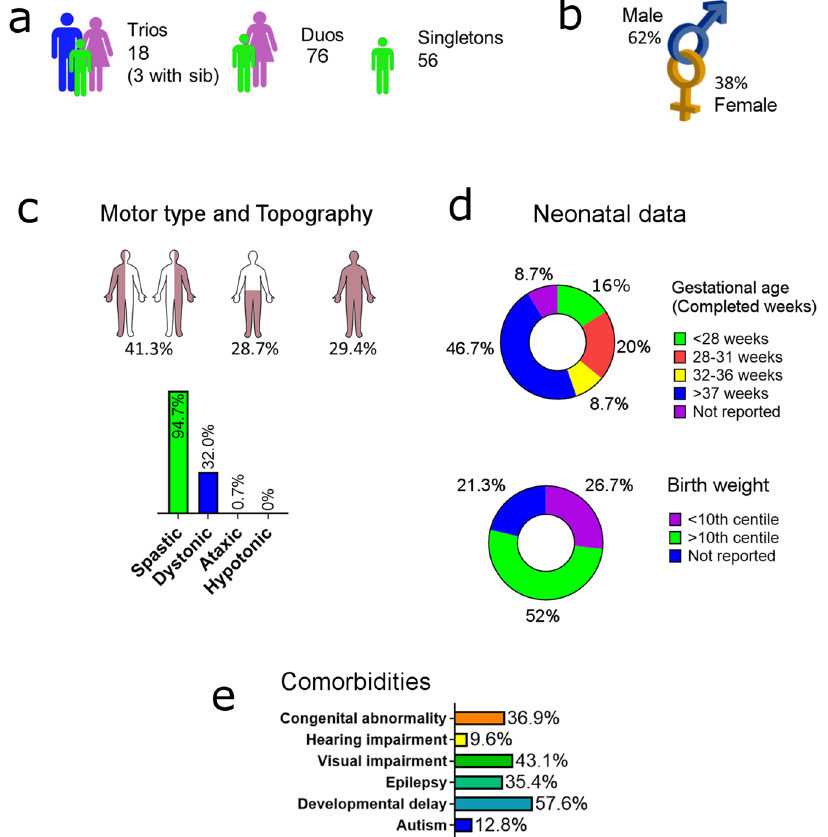
Fig. 1 Summary of clinical characteristics of the study cohort. Clinical descriptions for each individual in the cohort are in Supplementary Table 1. a Availability of parental samples. b Sex. c Motor type and Topography ( n = 150): Cases were classi fi ed according to topography categories: hemiplegia, diplegia or triplegia/quadriplegia. For motor type, cases with any report of dyskinetic/dystonic motor type are reported as dystonic. d Neonatal data: Gestational age was con fi rmed by case note review ( n = 137). Personalised birth weight centiles for this cohort were calculated using the Gestation Related Optimal Weight (GROW) software 67 which accounts for individual physiological pregnancy variables ( n = 118). e Comorbidities: Comorbidities were reported by parents and con fi rmed by clinical review where possible. Developmental delay reported in this cohort may include intellectual delays, as well as motor and other developmental delays. Data available: Autism n = 113, Developmental delay n = 130, Epilepsy n = 124, Visual impairment n = 116, Hearing impairment n = 110, Congenital abnormality n =